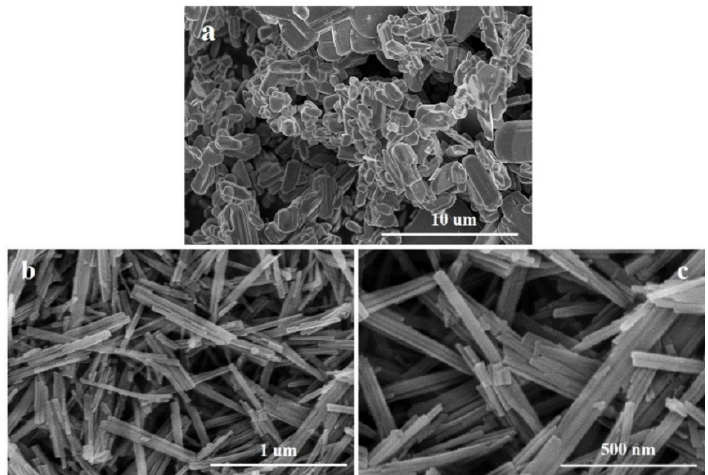
Figure 2. SEM images of commercial MoO 3 ( a ) and MoO 3 nanobelts ( b , c ).